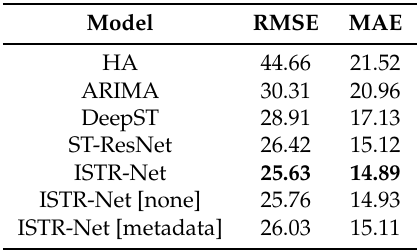
Table 1. Comparison with different